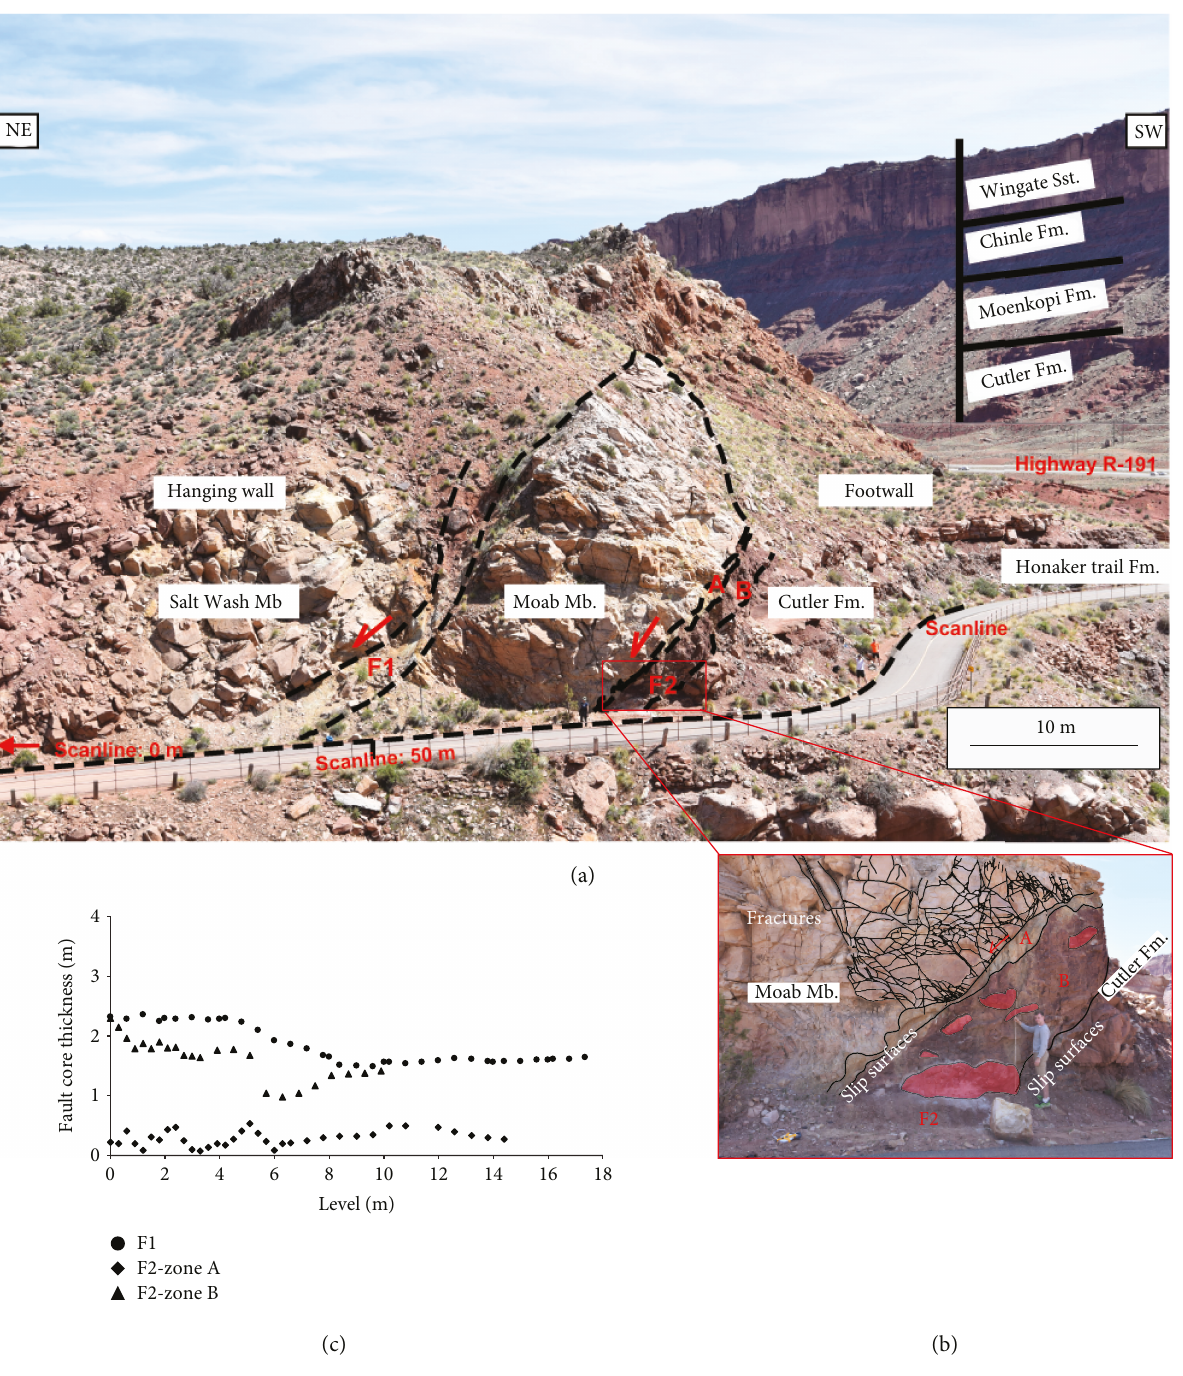
Figure 4: (a) Outcrop photo of the R-191 Canyon locality in Utah with a short description of stratigraphy and displaced formations. Note the locations of F1 and F2 (zones A and B) along the scanline at the base of the outcrop. (b) The inset is a closeup of the lower part of F2 zones, A and B. (c) Fault core thickness measured at di ff erent levels of the fault cores at this